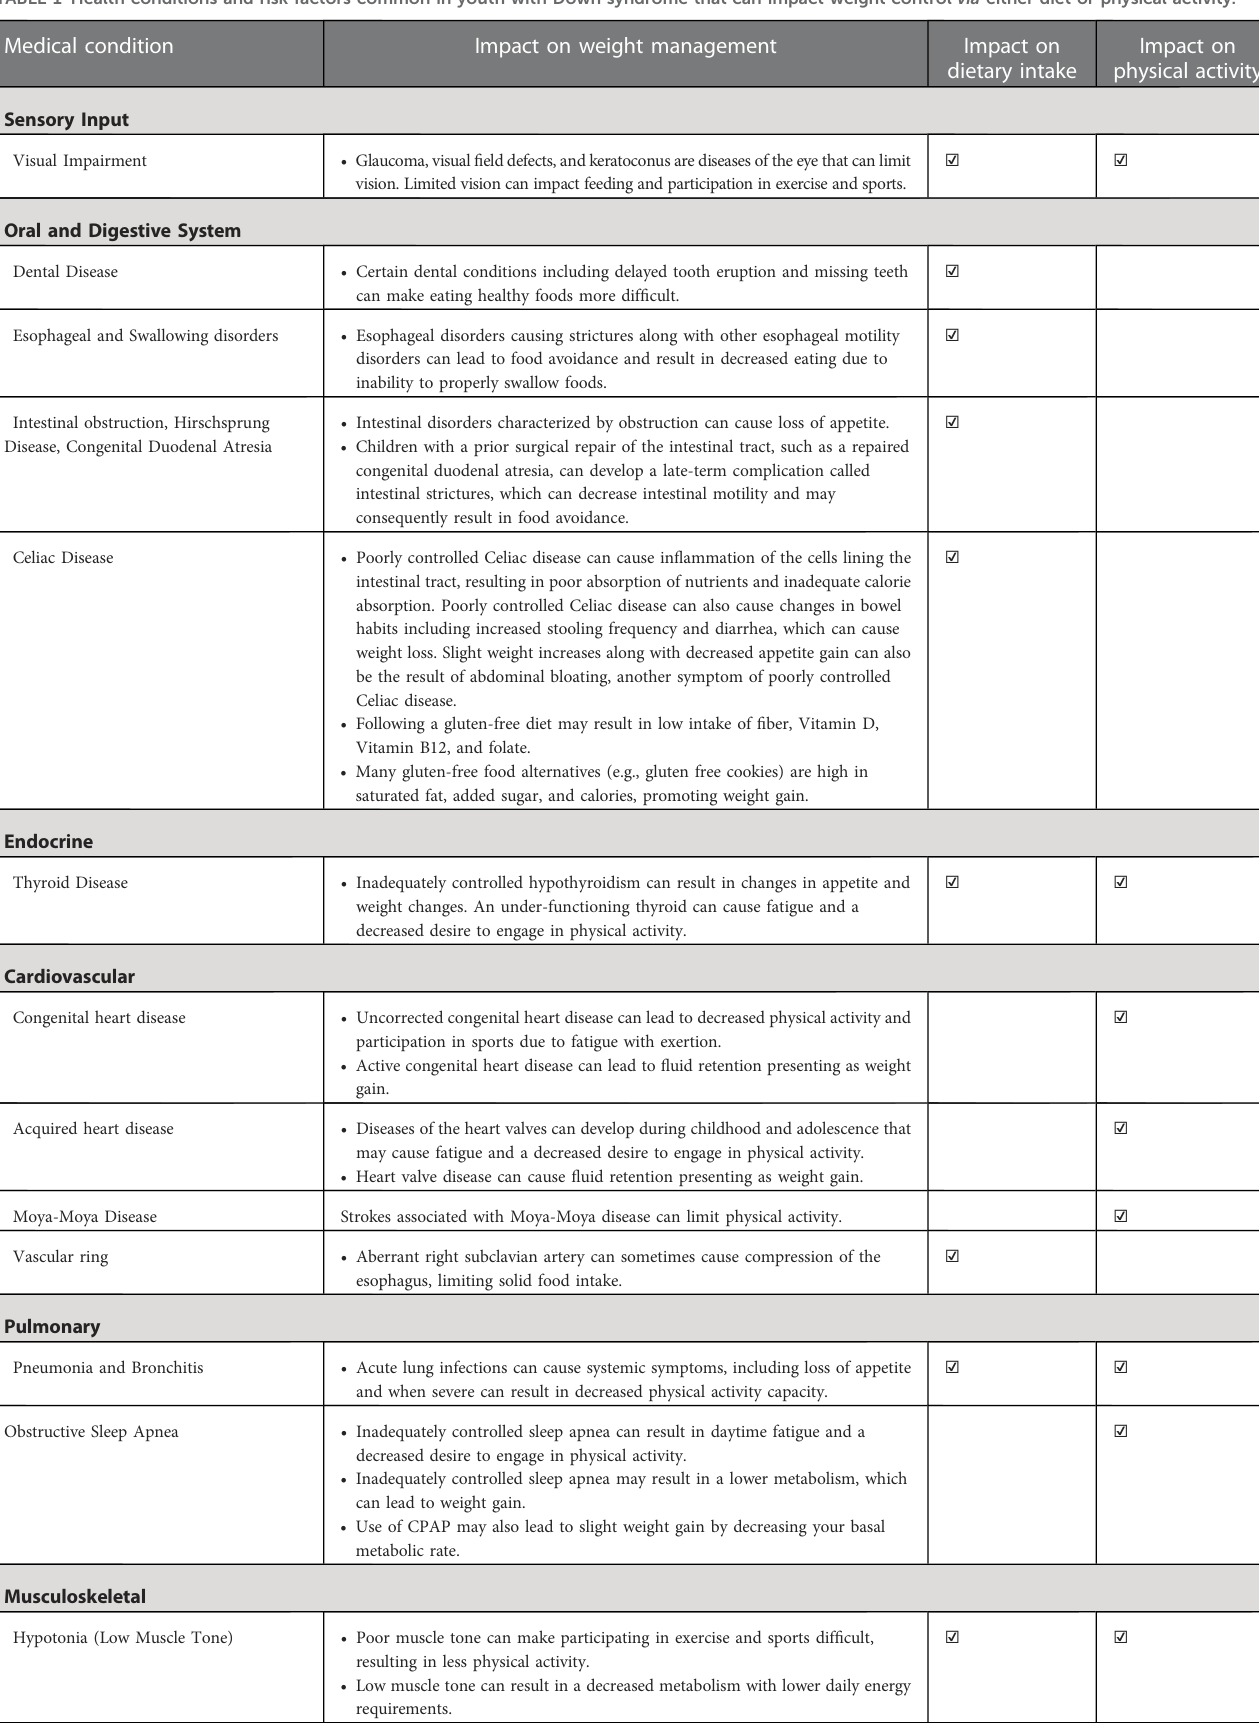
TABLE 1 Health conditions and risk factors common in youth with Down syndrome that can impact weight control via either diet or physical